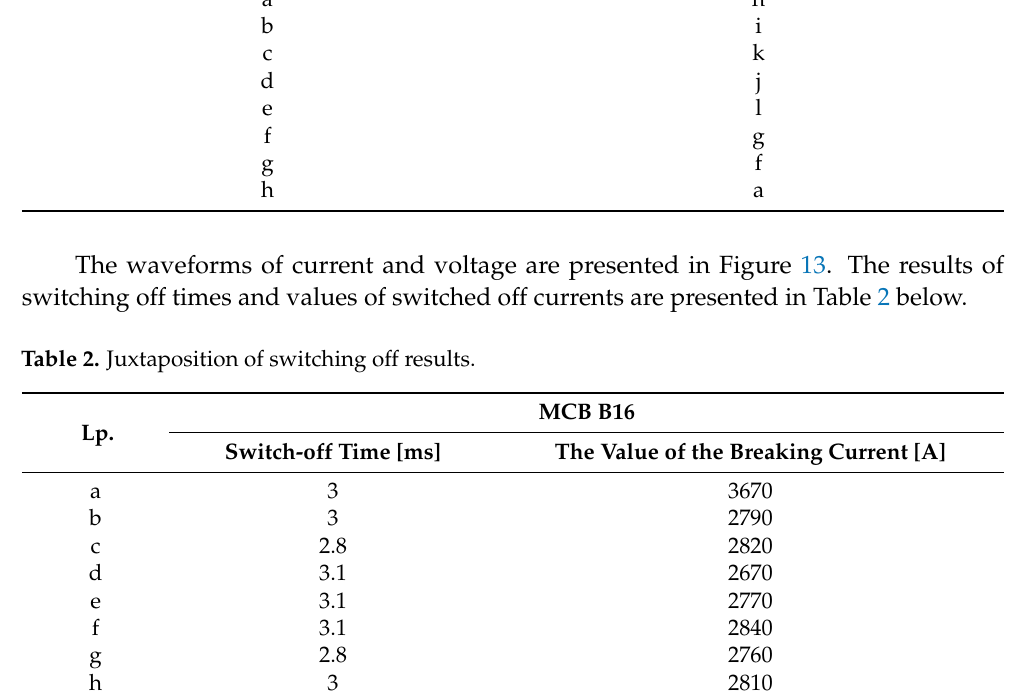
Table 1. Correlation chart between oscillograms and the plates photographs. Correlation Chart Figure 15